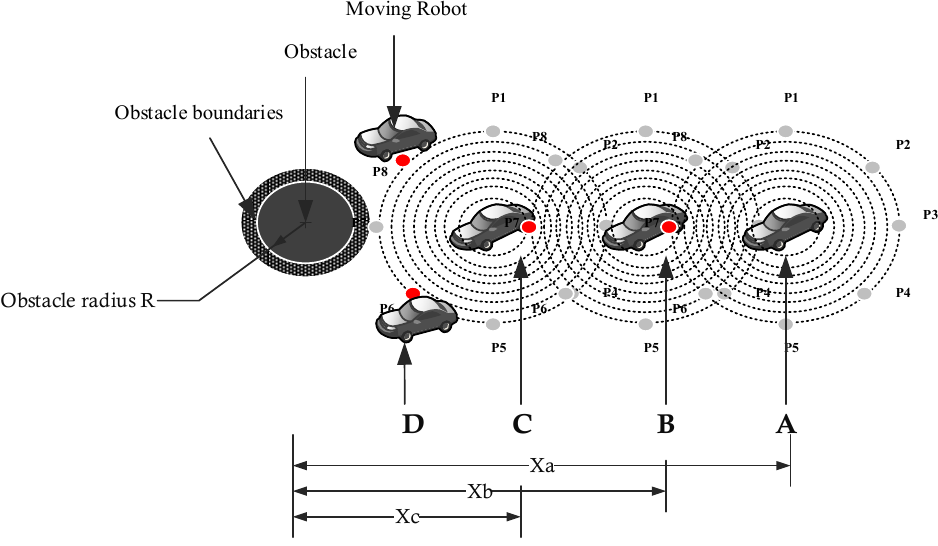
Figure 5. Static obstacle collision avoidance.